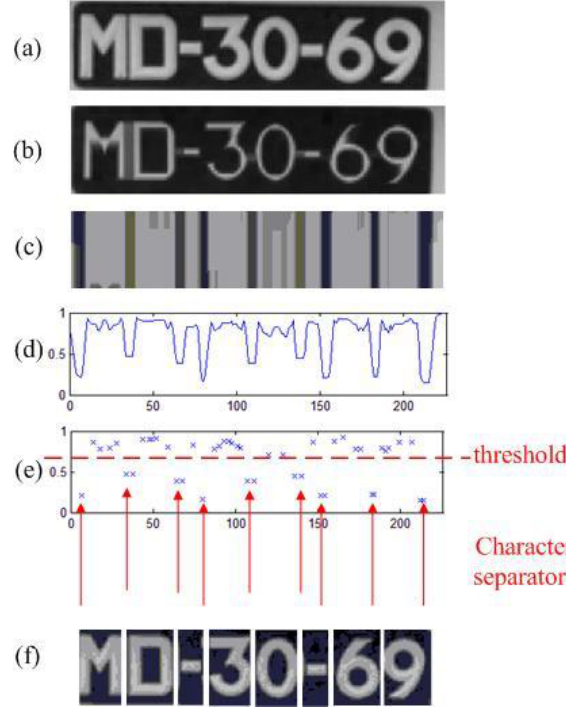
Figure 11: Character Segmentation. (a) Extracted plate image. (b) Eroded image. (c) Dilated image. (d) Vertical projection. (e) Local minima graph and threshold selection. (f) Resulting character